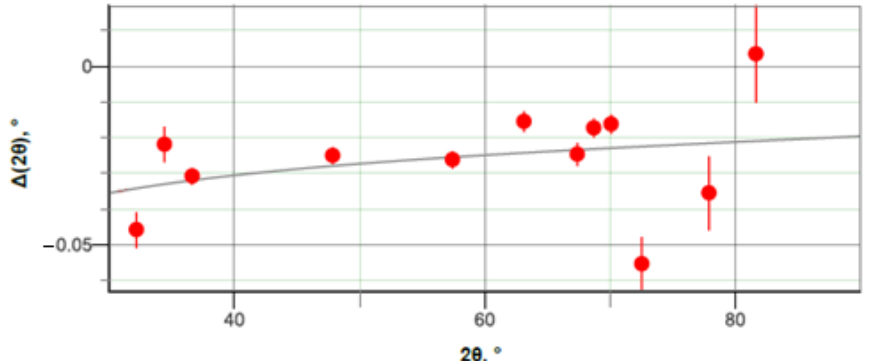
Figure 3. Δ(2θ) graph for identifying the unit -cell parameters.